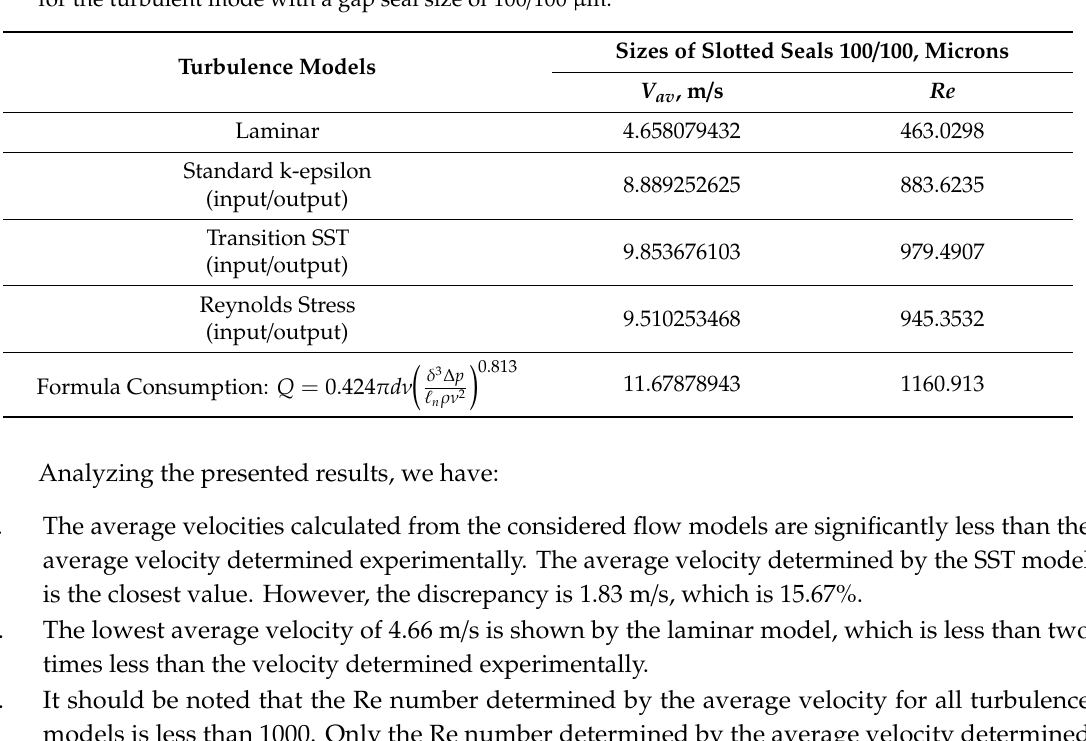
Table 3. Average fluid velocities in the gap and Reynolds numbers determined by di ff erent flow models for the turbulent mode with a gap seal size of 100 / 100 µ